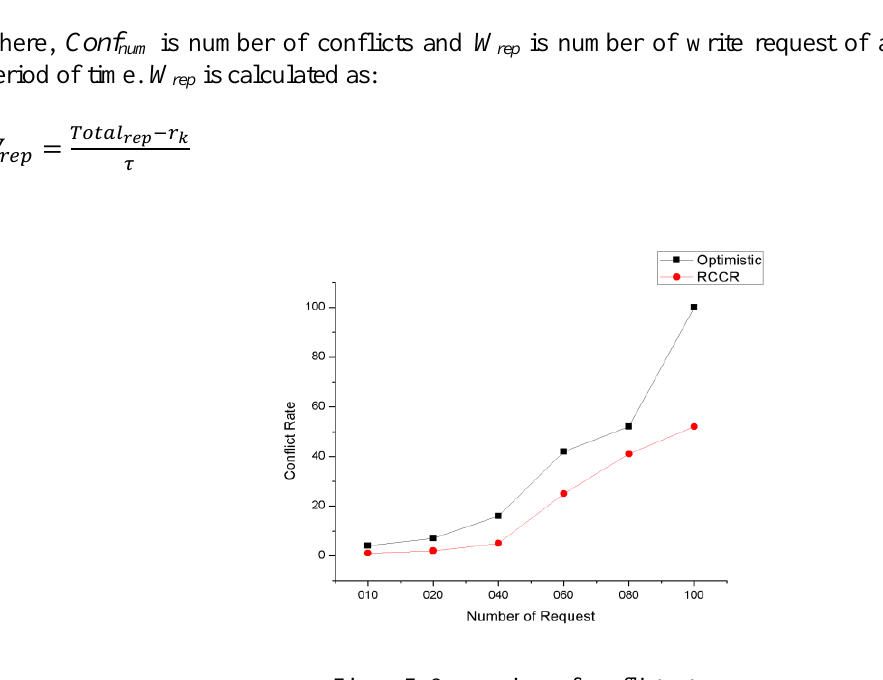
Figure 7. Comparison of conflict